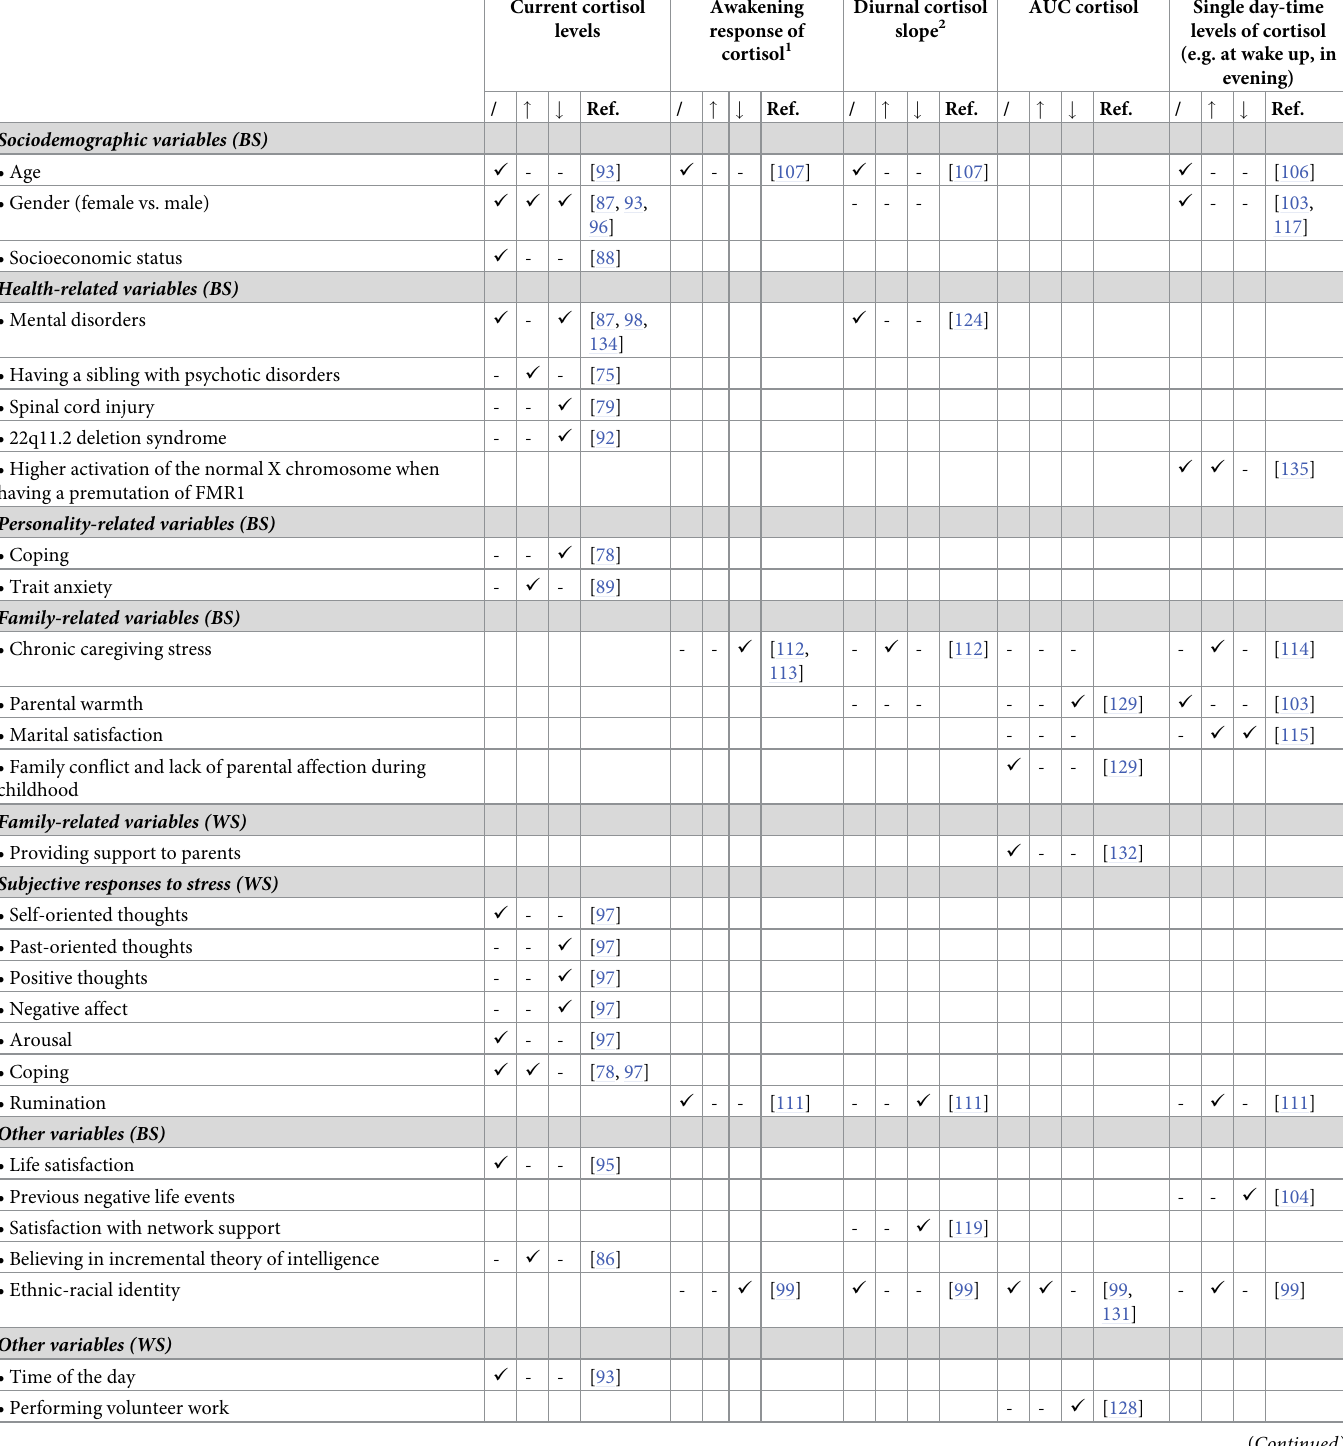
Table 3. Moderating variables on within-subject associations between acute stressors or stress and